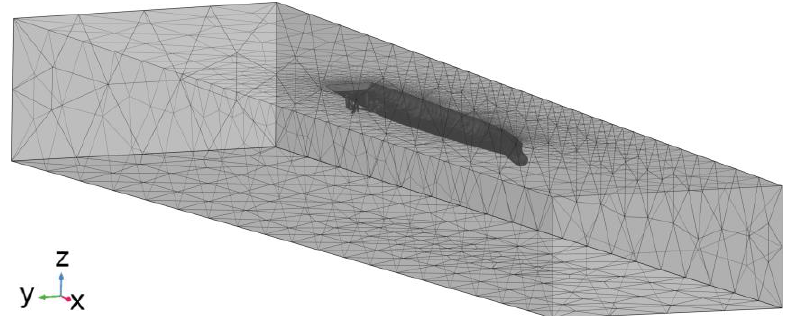
Figure 3. Three-dimensional model of ship corrosion electric field and mesh subdivision results.